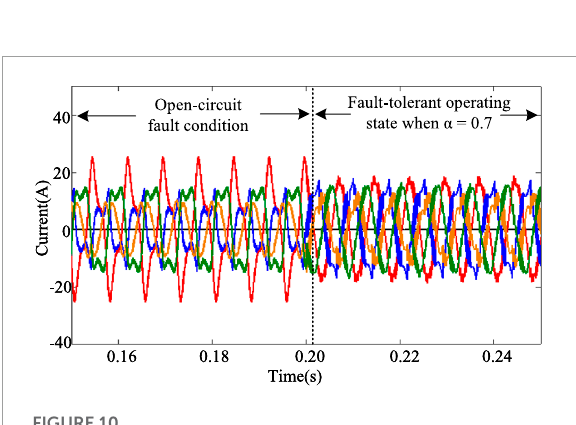
FIGURE 10 Current under the condition of motor fault and FT when α = 0 . 7.